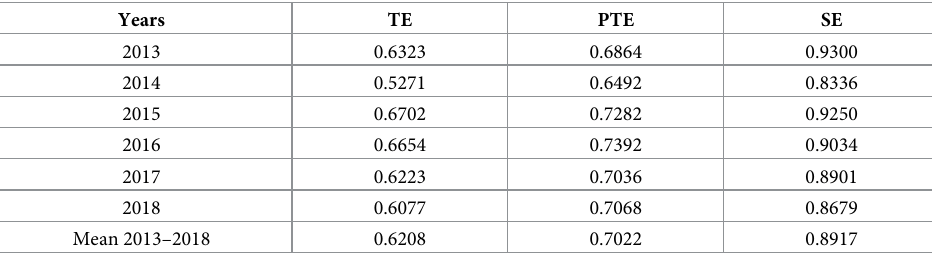
Table 4. Years-wise mean operational efficiency scores of all 147